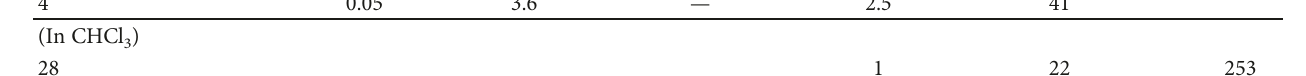
Table 2: E ff ects of laser fl uence (in μ J/cm 2 ) on maximum populations of triplet state formation ( η ) and total charge transfer state formation CT ( η ) together with the lifetimes of CT states ( τ ) and triplet states ( τ ) as well as the rise times for the triplet states ( τ n Trise ) obtained for CT T T COARSE as well as for FINE blend fi lms. Also shown are the lifetimes of the Franck-Condon state ( τ ), of the hot singlet state ( τ ∗ FC and of the hot CT state ( τ ∗ CT